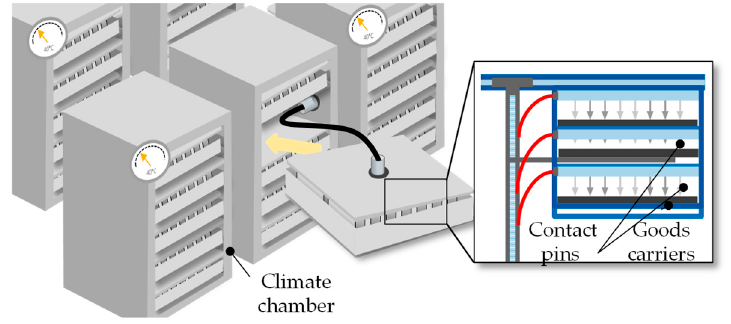
Figure 5. Schematic of pre-charging and formation [9].